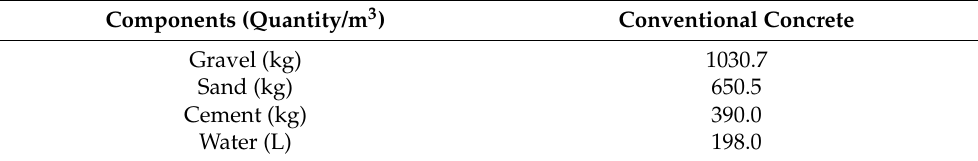
Table 1. Concrete mixture components. Table 1 . Concrete mixture components.